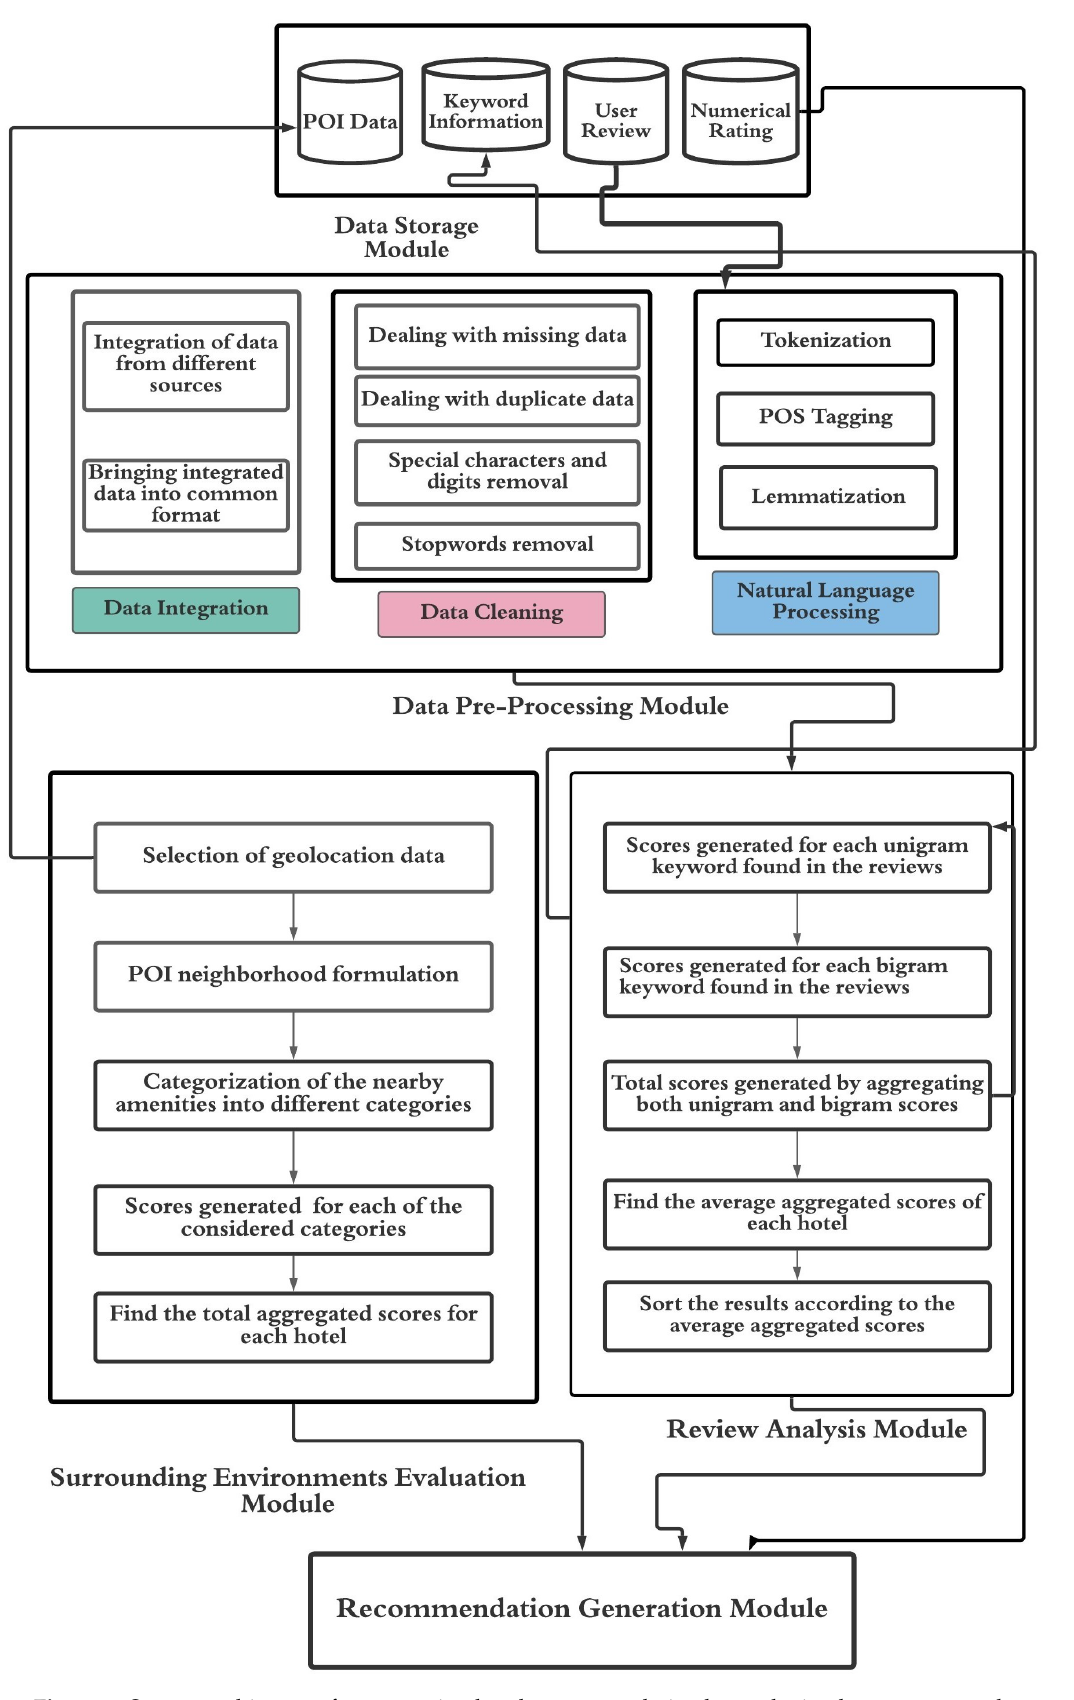
Figure 3. System architecture for generating hotel recommendation by analyzing heterogeneous